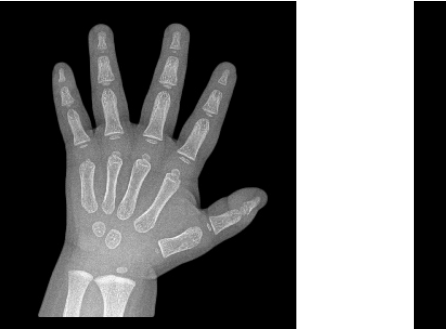
Figure 1. Three-stage metacarpal X-ray images.